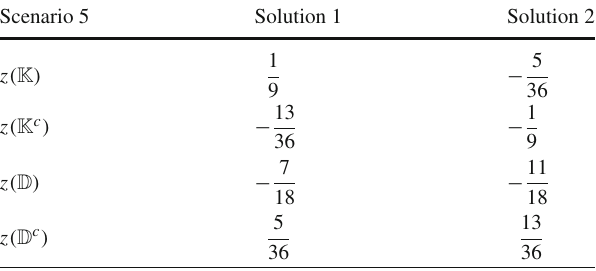
Table29 Valuesofthe U ( 1 ) (cid:2) chargesfortheexoticquarksinU μν SSM models using solution (30) with the hypercharges of Case 1 of Table 10. The U ( 1 ) (cid:2) charges of the rest of the fields are given in Table 2 and